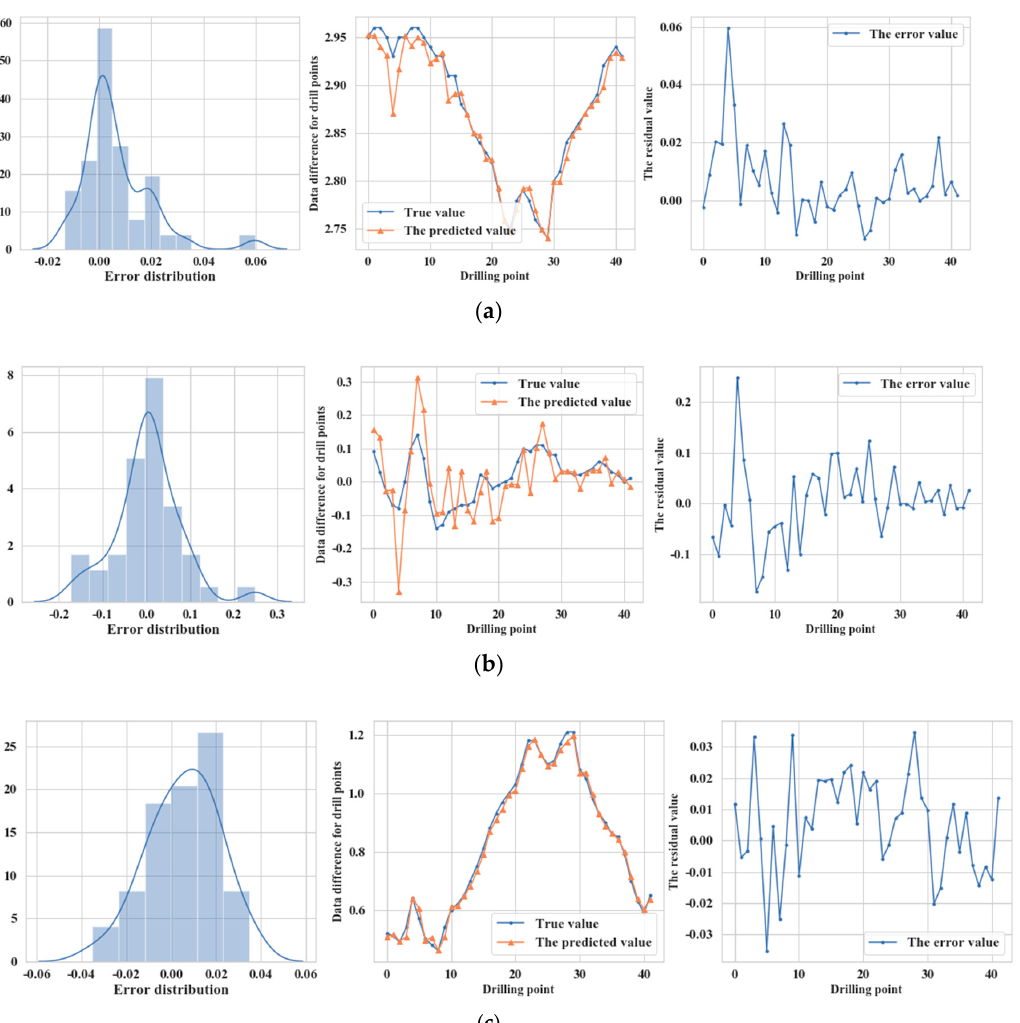
Figure 4. Residuals between predicted and actual values. ( a ) Horizontal. ( b ) Left and right direction. ( c ) Up and down direction.